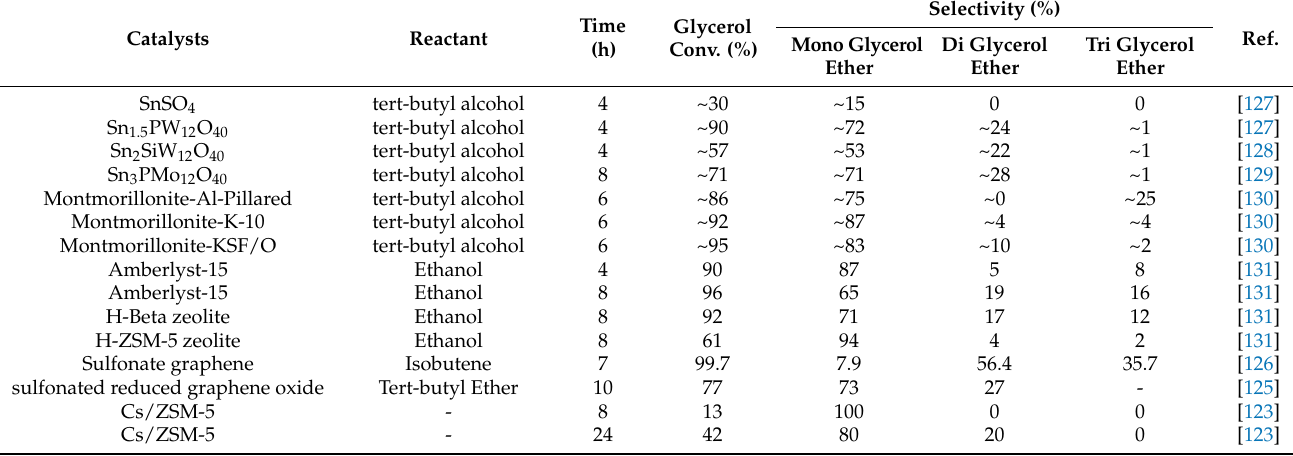
Table 4. Performance of different catalysts used in etherification of